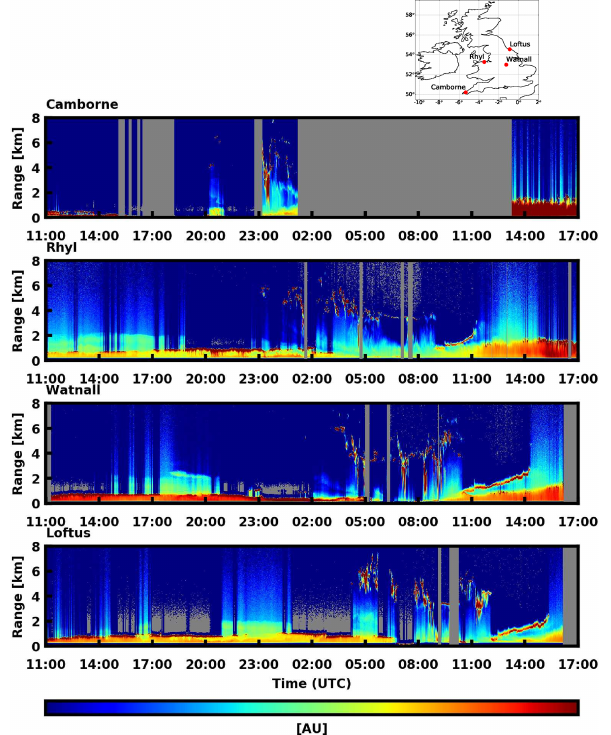
Figure 7. Range- and molecular-attenuation-corrected signal for 15 and 16 October 2017 from four Met Office lidars. The locations of the four sites are shown in the map at the top of the figure. Grey areas indicate no data.